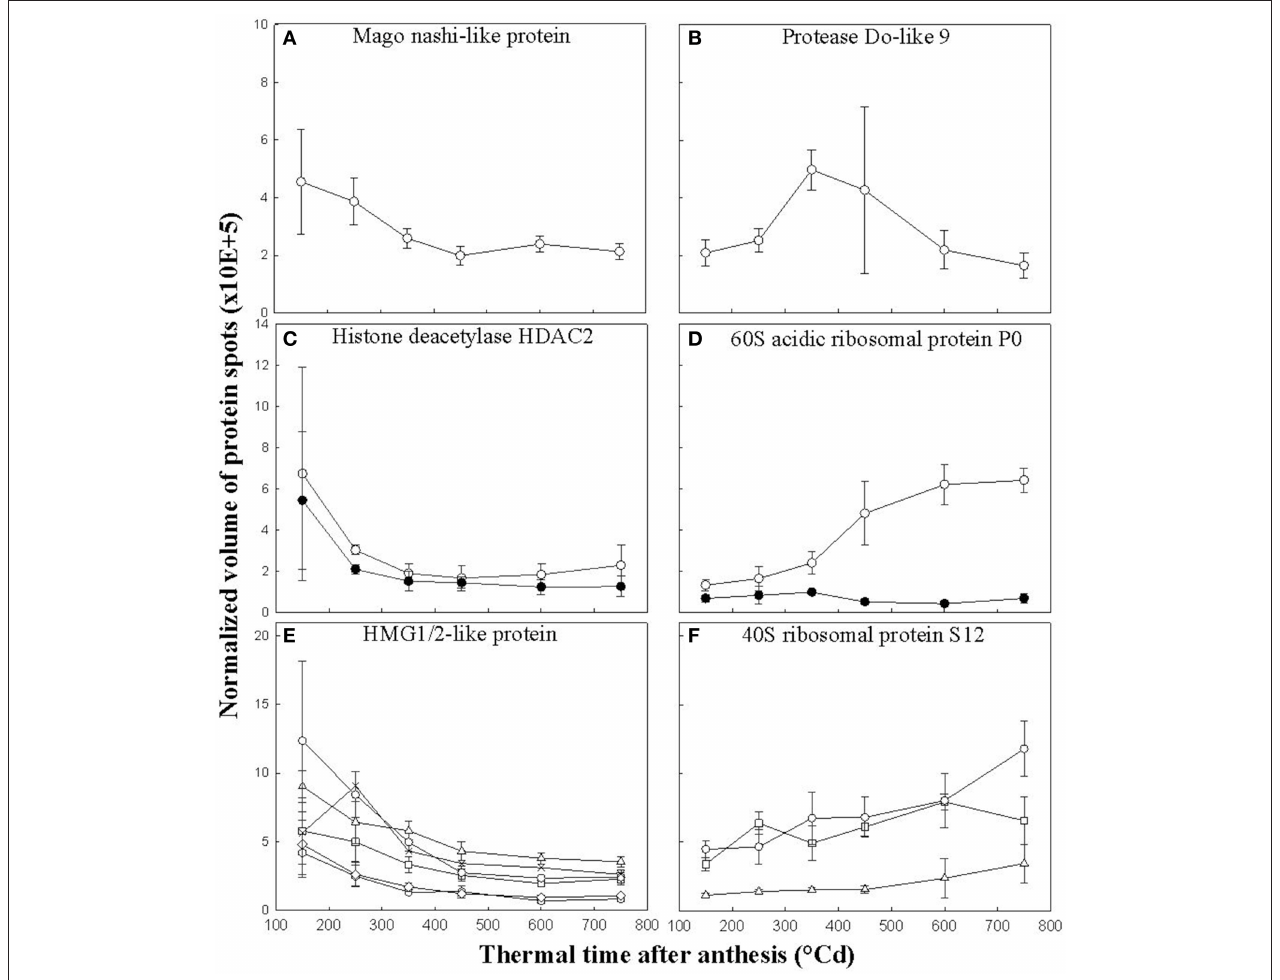
FIGURE 6 | Changes in volumes of several nuclear protein spots. Mago nashi-like protein (A) and protease Do-like 9 (B) were each identified in only one spot whose abundance varied significantly during grain development. Histone deacetylase HDAC2 (C) and 60S acidic ribosomal protein P0 (D) were each found in two spots including one which varied significantly (open circles) and one which did not vary significantly during grain development (closed circles). HMG1/2-like protein was identified in eight spots including six that varied, presented graphically in (E) . The 40S ribosomal protein S12 (F) was found in three spots whose volumes varied significantly during grain development. Data are means ± 1 s.d. for n = 4 independent